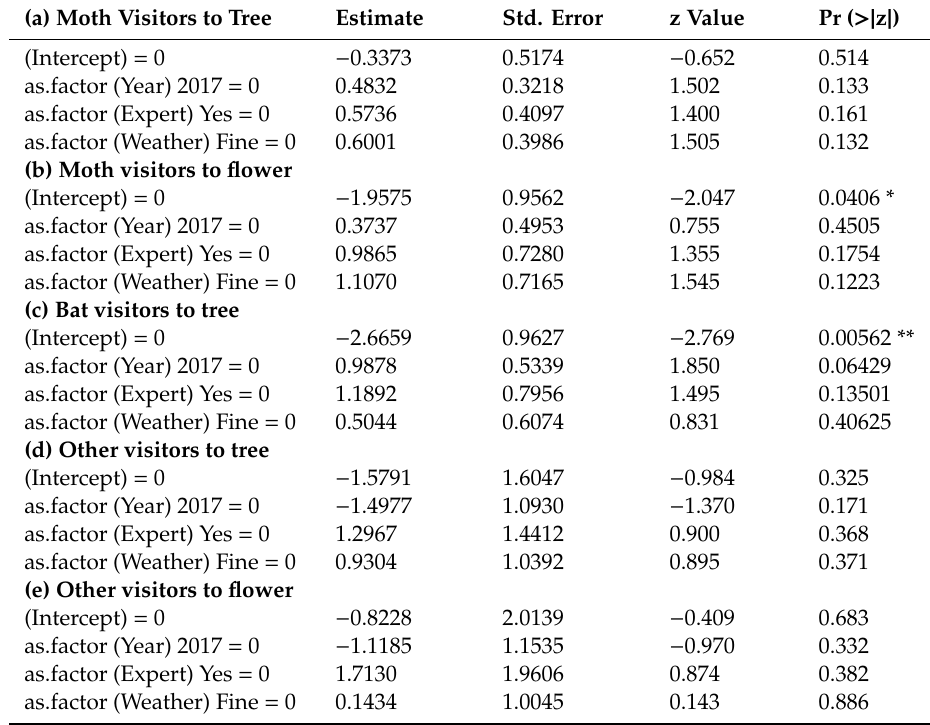
Table A2. Generalized linear models with quasipoisson correction and o ff set to correct for e ff ort (log (person-hours)), for the relationship of di ff erent tree and flower visitor counts per tree-night with observer qualification (expert or not), weather (fine or bad), and year (2016 or 2017). Variables were compared with default values for Expert (“Yes”), Weather (“Fine”), and Year (2017). Thus, Year tests for di ff erences between 2016 and 2017 and a negative estimate indicates lower activity in 2016 compared with 2017. P ( >| z | ) is the tail area in a 2-tail test, with the z value as the Wald statistic for testing the hypothesis that the regression coe ffi cient is